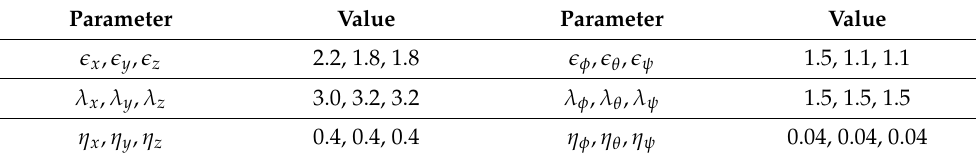
Table 2. Controller parameters.